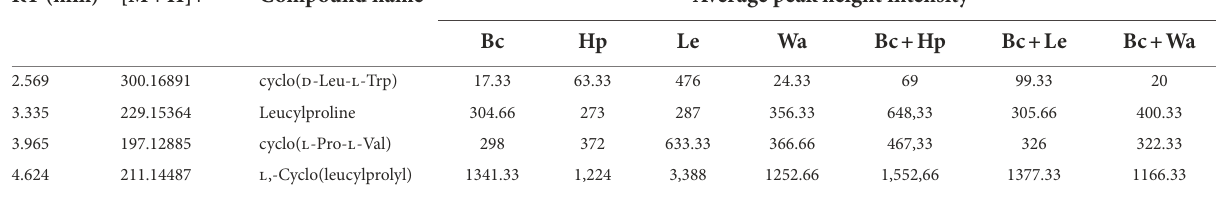
TABLE 4 Analysis of non-volatile organic compounds produced by B. cinerea (Bc), H. pseudoburtonii (Hp), W. anomalus (Wa) and L. elongisporus (Le). RT (min) [M + H]+